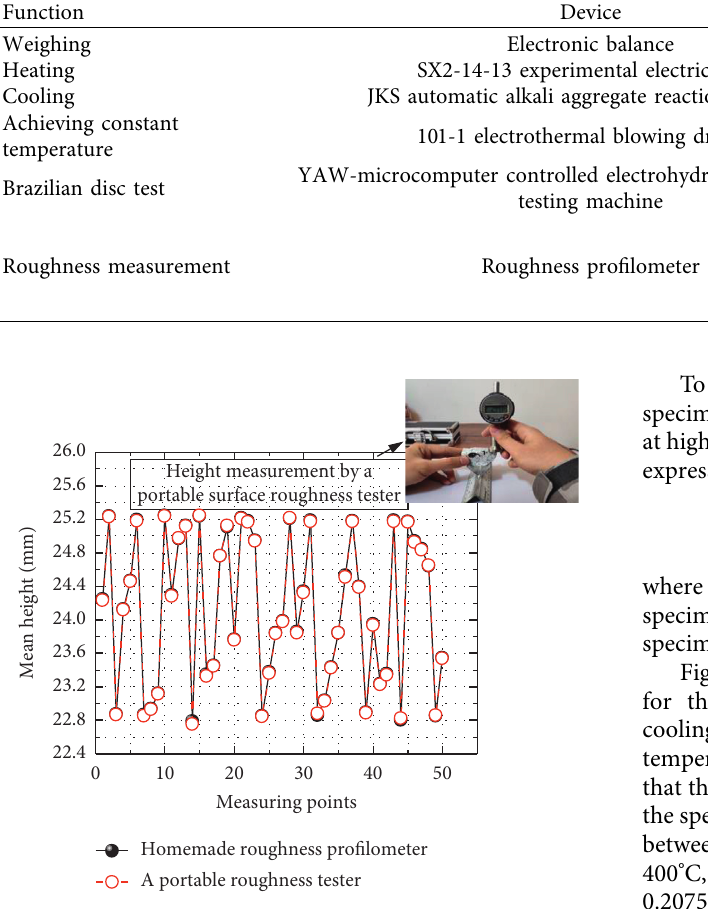
Figure 3: Verification of the accuracy of the homemade roughness